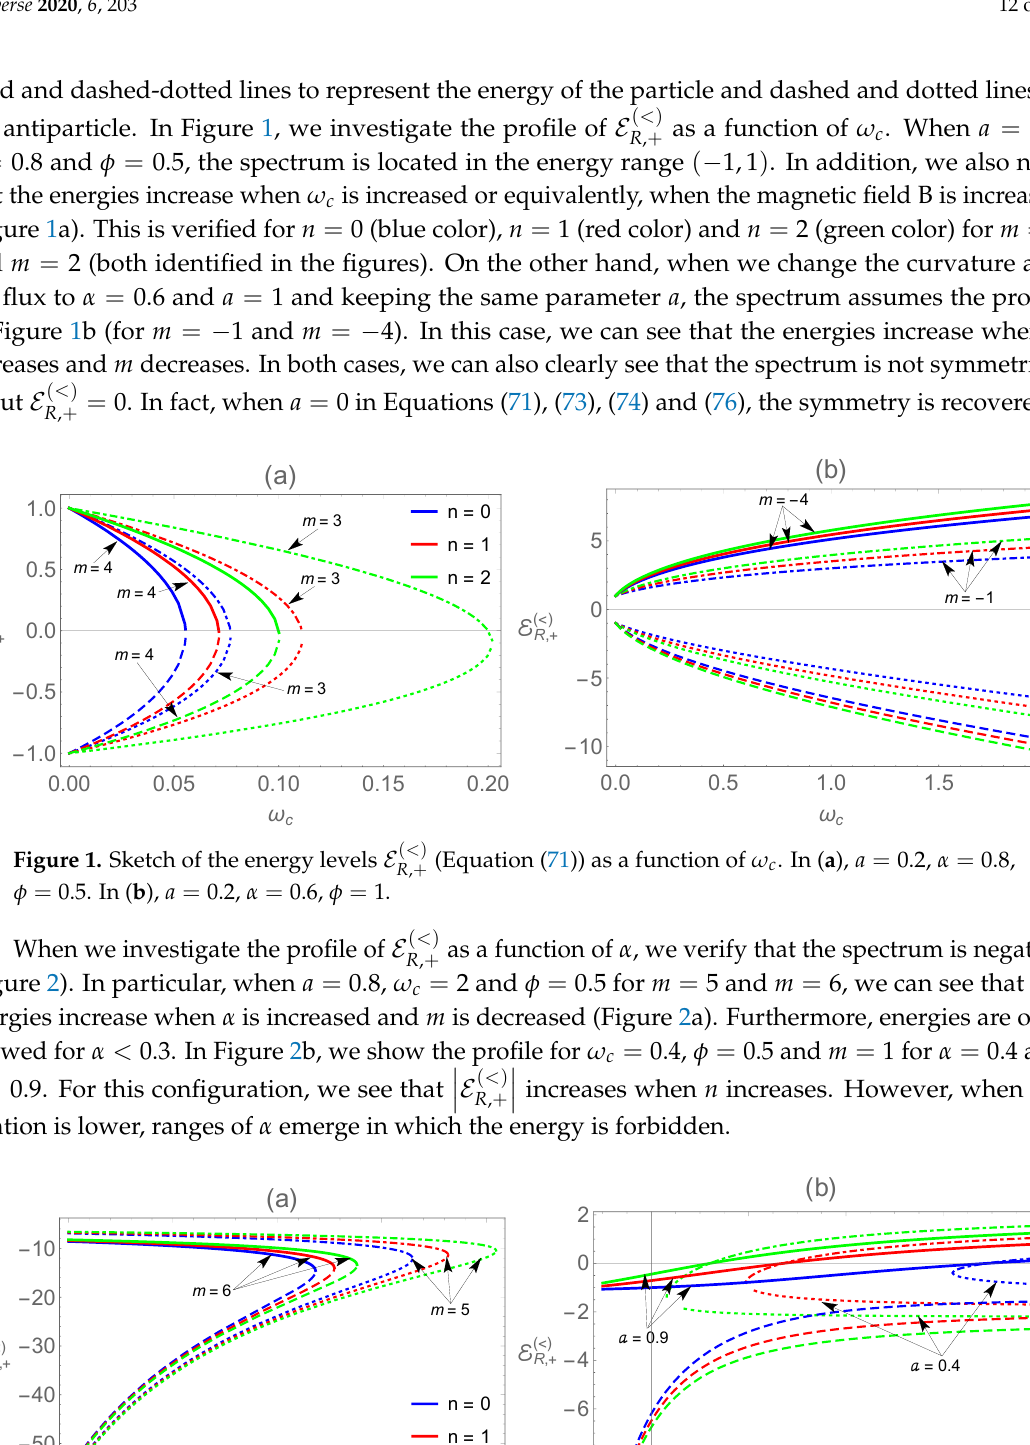
Figure 2. Sketch of the energy levels E φ = 0.5. In ( b ), a = 0.4, ω = 0.4 and φ =